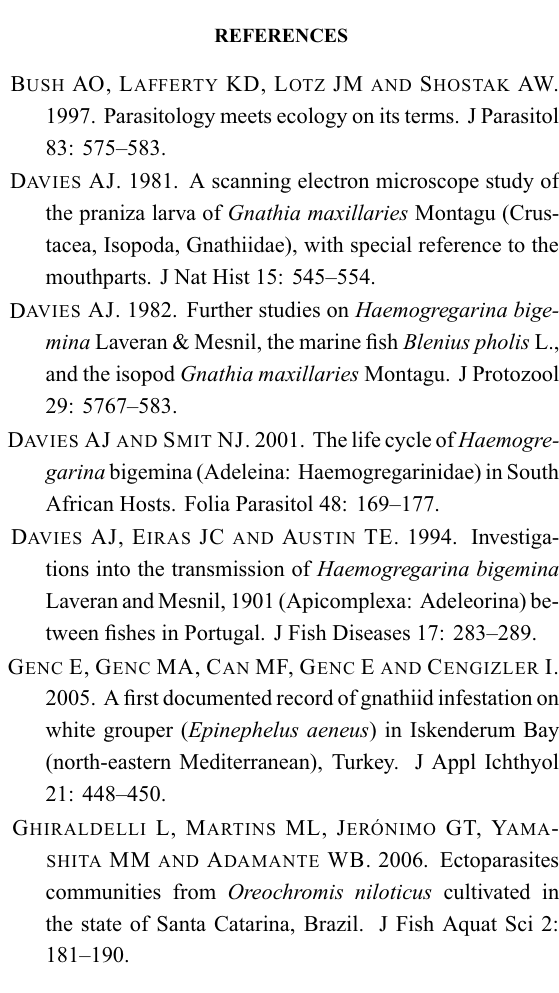
Comparison of the morphological characteristics of praniza larvae of this study and the praniza larvae of others species. Total L Teeth on Teeth on tip Teeth on Teeth on Setae on Species (mm) the mandible of mandible the maxillipede the maxillule the pleotelson Present study 2 . 0 ± 0 .